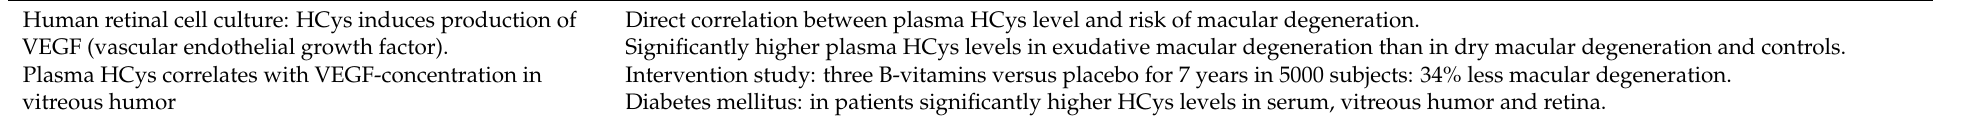
Table A10. Vision loss: exudative macular degeneration, diabetic retinopathy— Rev